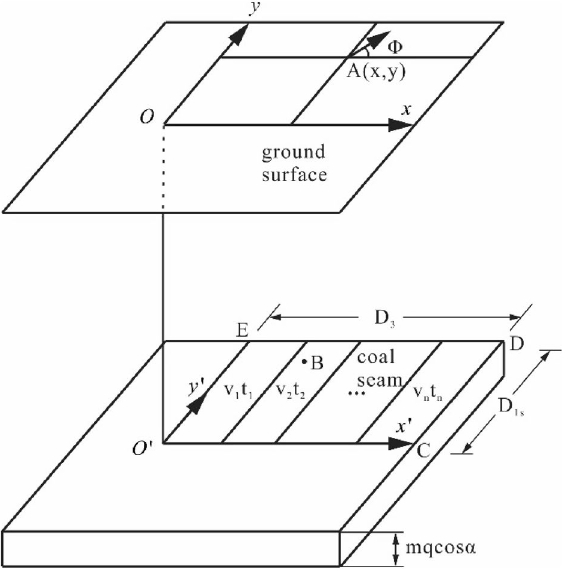
Figure 3. Influence of unit mining on arbitrary points on the